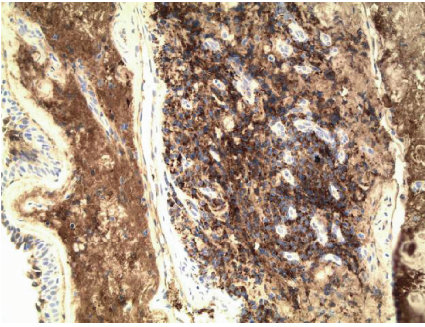
Figure 6: Photomicrograph of surgical specimen. The plasma cells express cytoplasmic immunoglobulin with light chain